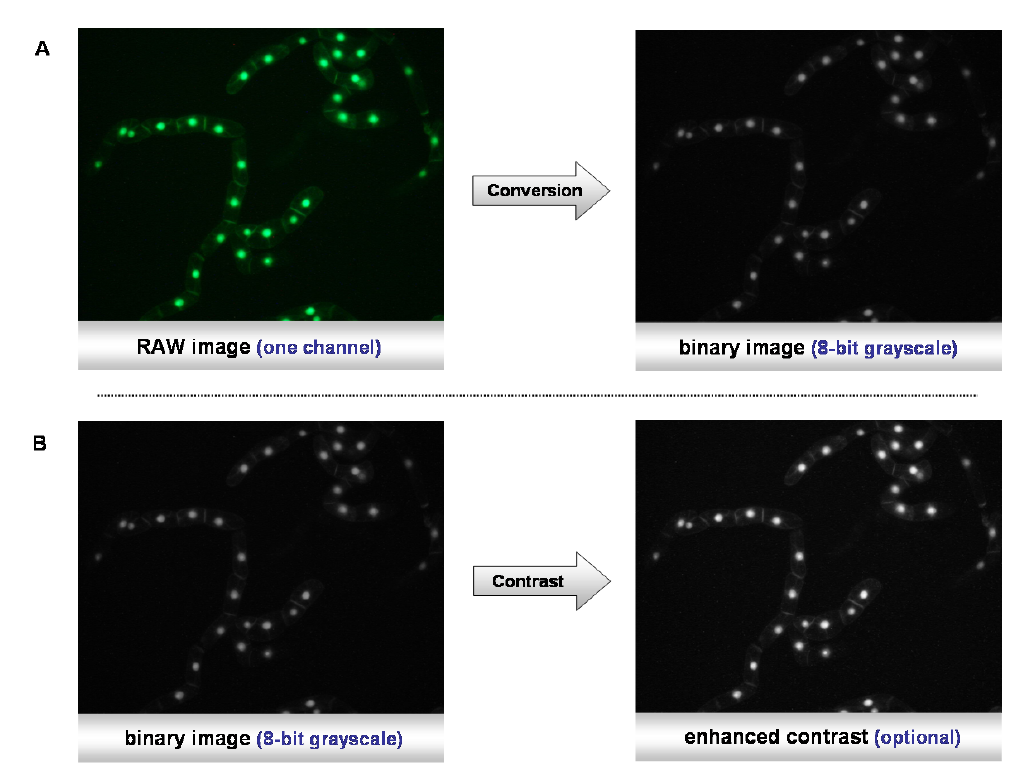
Figure 2. First steps of the segmentation process. A ) Conversion of the RAW color image to a binary image file. B ) Enhancement of the